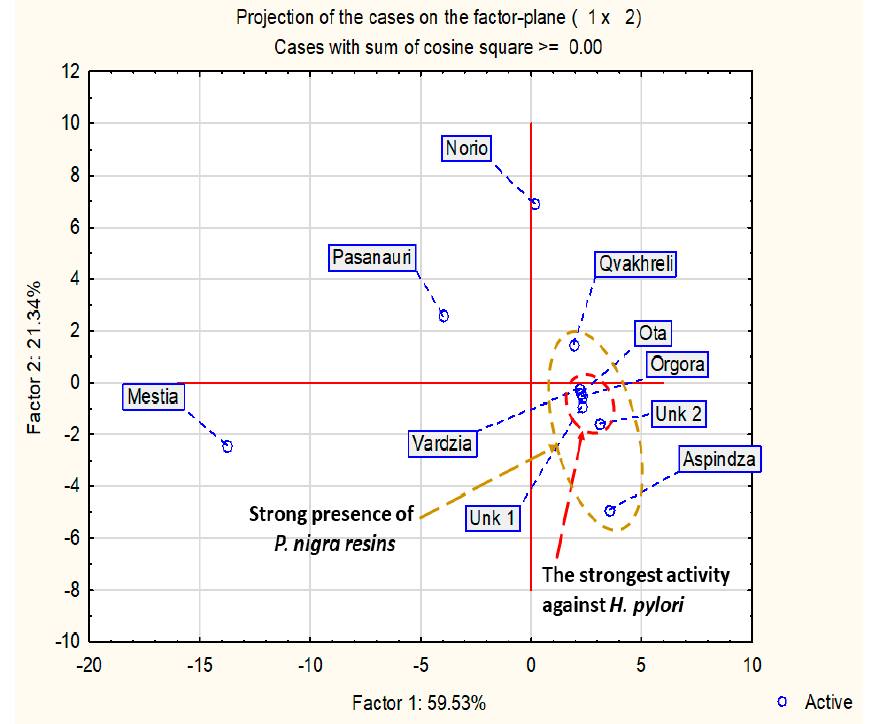
Figure 2. Projection of cases on the factor plane .